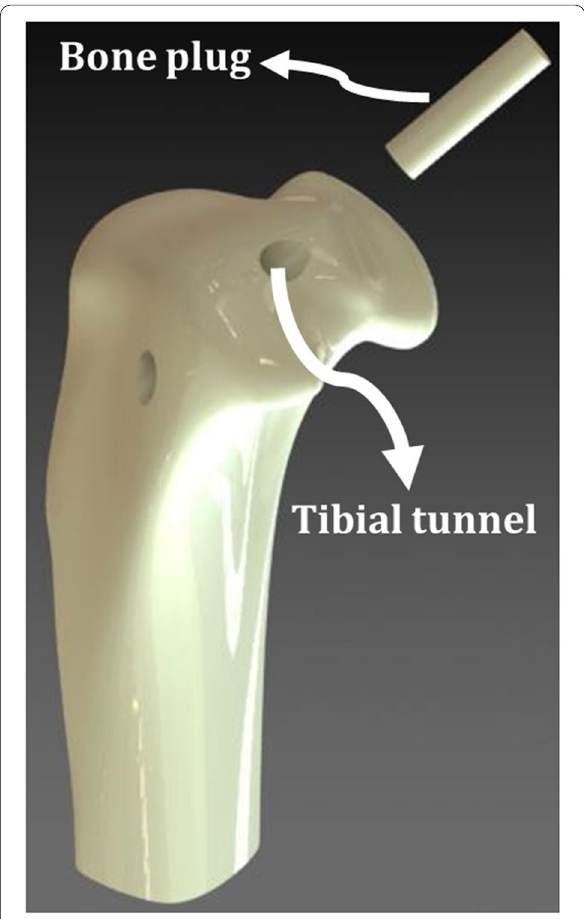
Fig. 1 ACL reconstruction using Core Bone Plug Fixation (CBPF) technique. The bone plug is cut and harvested during bone